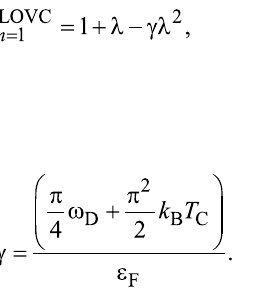
Figure 4: The ratio of the electron effective mass to the electron band mass as a function of temperature. The results were obtained in the framework of LOVC model, ME model, and Equation 9. The lines for ME results can be reproduced using the